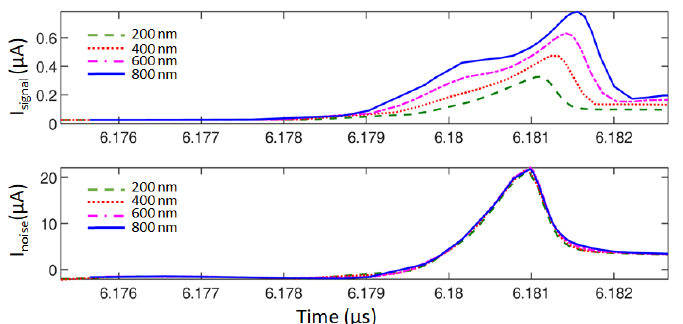
Figure 8. Signal and noise currents drawn from the power supply for different gate widths of the target signal load in adiabatic SIMON core.